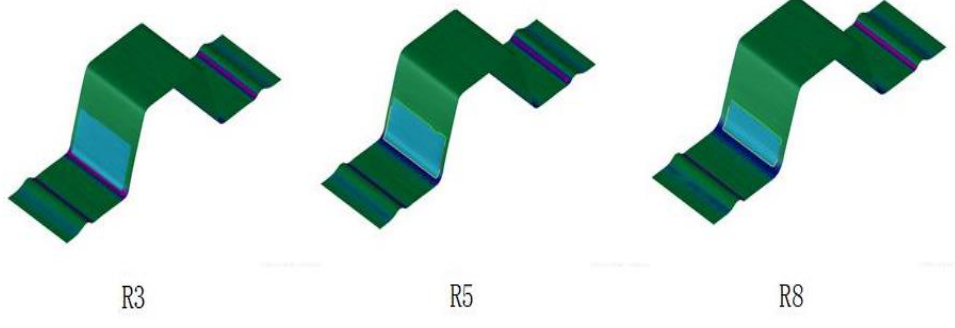
Figure 16. Skid lines at different die fillets.